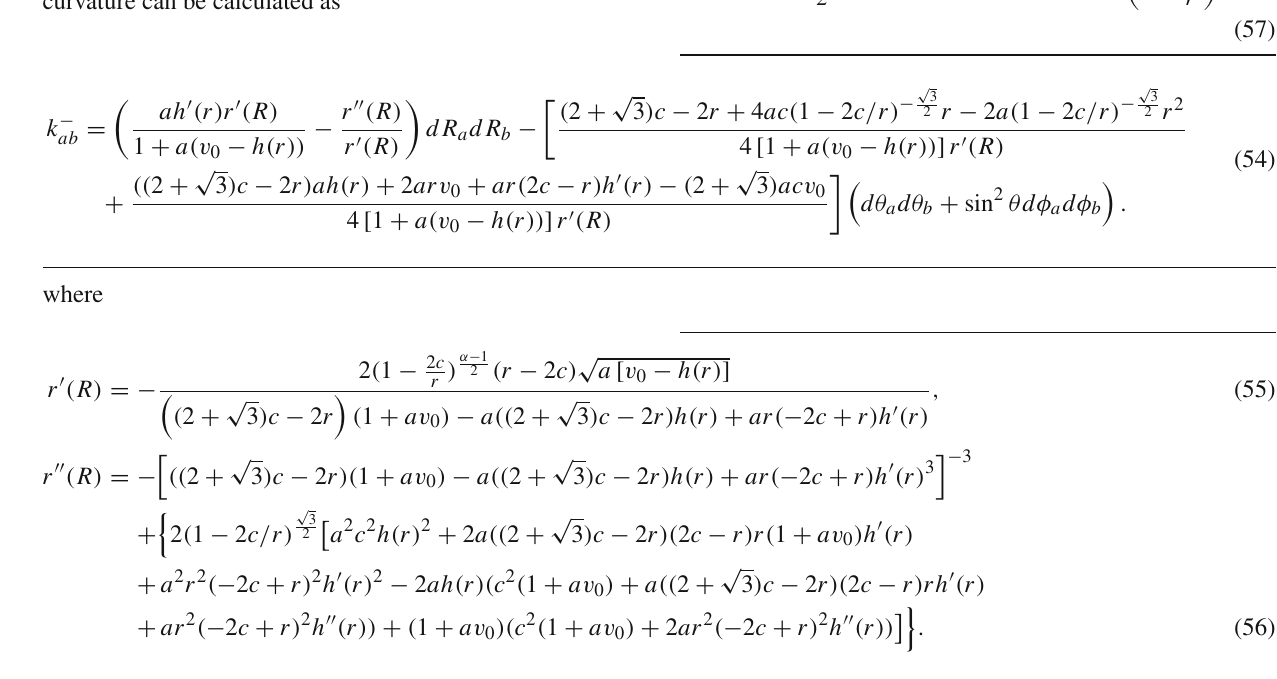
Similarly to Sect. 3, we match the solution onto an outgo- ing Vaidya solution at the null hypersurface v = v 0 (see Fig. 3). Substitution of v = v 0 into Eq. (53) yields the func- tion r = r ( R ) . By the method in Sect. 3.1, the extrinsic curvature can be calculated